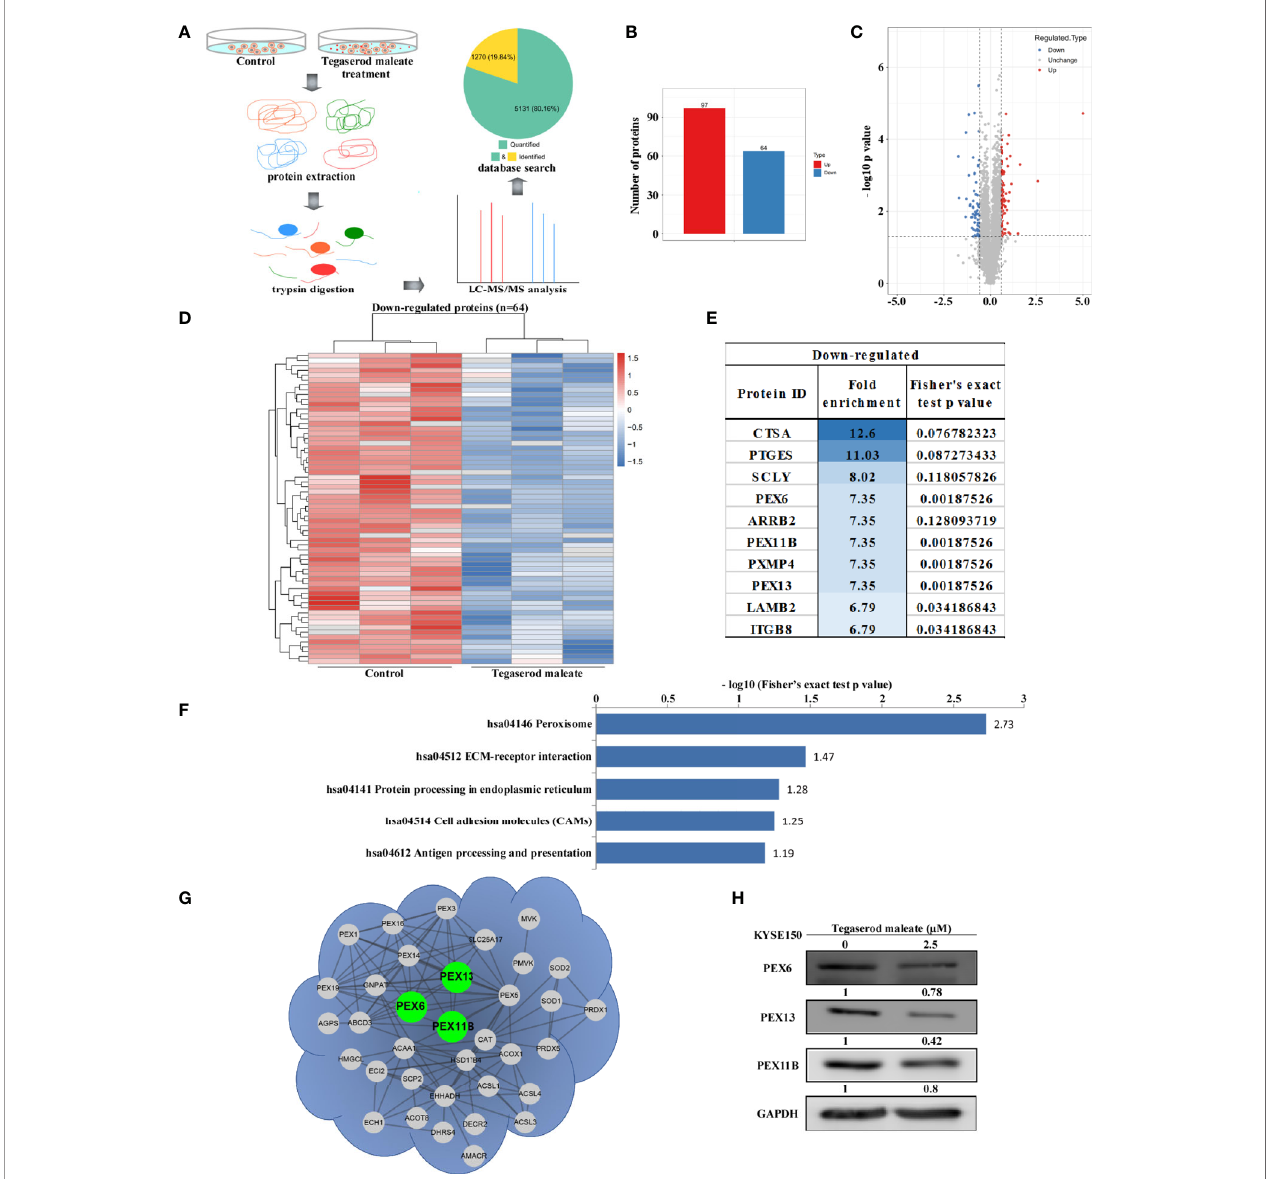
FIGURE 2 | Proteomic analysis suggests that tegaserod maleate inhibits ESCC cells via the peroxisome pathway. (A) After tegaserod maleate treatment (2.5 m M) for 24 h, the general procedure of the experiment is to illustrate the proteomics process of KYSE150 cells. (B) A total of 161 differentially expressed proteins were detected. (C) Volcano plot shows that 161 proteins have undergone signi fi cant changes (fold change > 1.5, p < 0.05). Red dots represent upregulated proteins, and blue dots represent downregulated proteins. (D) The heatmap of down-regulated proteins after normalization (n = 64). (E) The top 10 differentially expressed proteins were ranked according to the enrichment score among the down-regulated proteins. (F) A bar chart representing the KEGG pathway enrichment analysis of down- regulated proteins enrichment that was altered due to tegaserod maleate treatment. (G) The proteins involved in peroxisome pathway identi fi ed after tegaserod maleate treatment were mapped to the network through the STRING database (con fi dence score > 0.7), in which the points are proteins. (H) Western blotting of tegaserod maleate-treated KYSE150 cells veri fi es the above